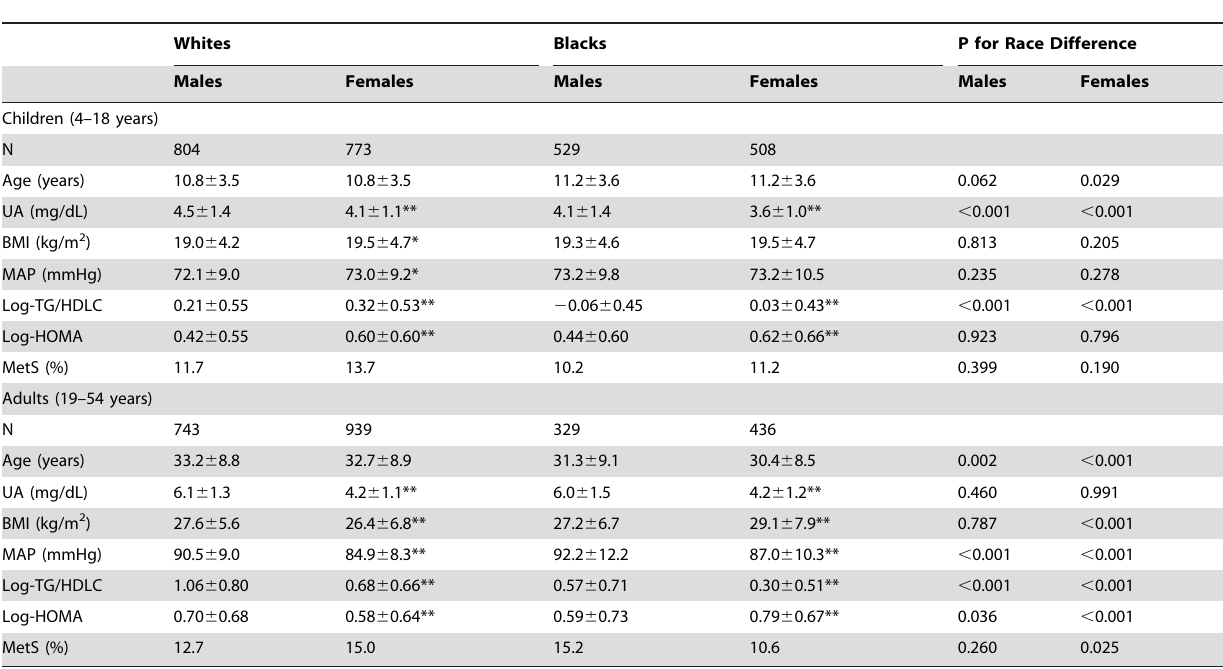
Table 1. Characteristics (Mean 6 SD, %) of study variables by race and gender.